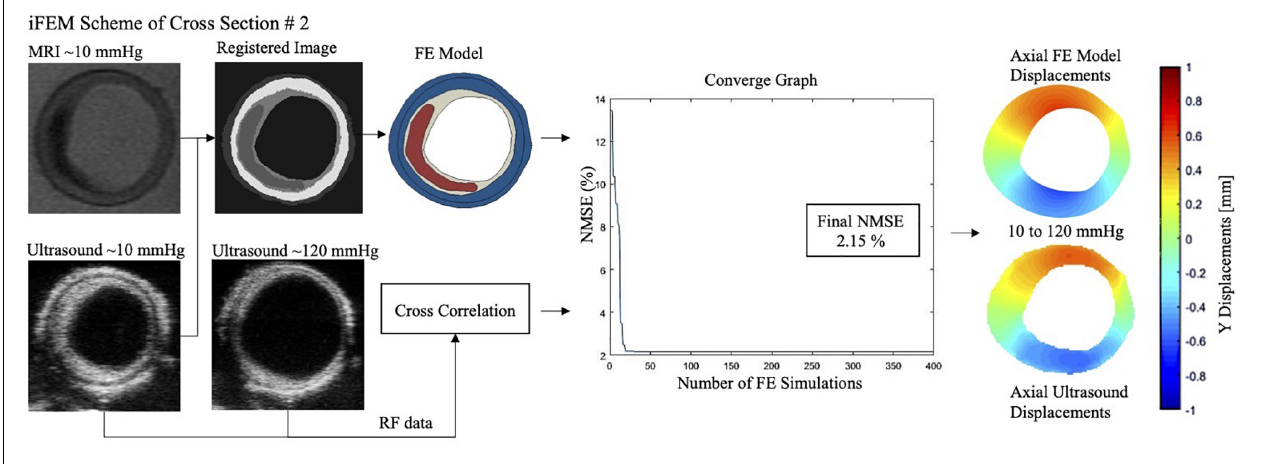
FIGURE 5 | Magnetic resonance imaging (MRI), ultrasound image (at 10 and 120 mmHg), finite element (FE) model, convergence graph and experimental and computationally derived final displacement maps demonstrated for the representative cross-section #2 with an error of 2.15%. NMSE, normalized mean square